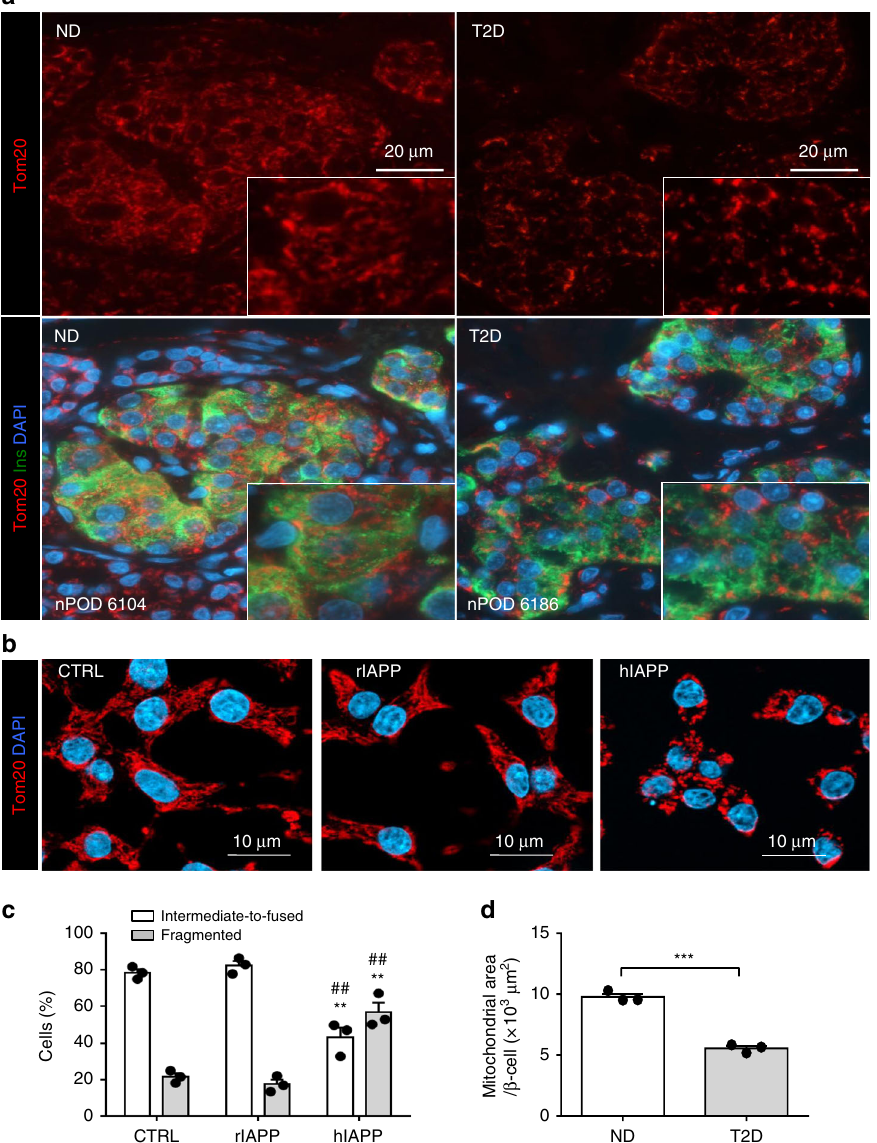
Fig. 4 β -cell mitochondrial fragmentation. a Representative immuno fl uorescence images of islets from non-diabetic (ND) and T2D patients stained for Tom20 (mitochondria, red), insulin (green), and DAPI (nuclei, blue). b Representative images of INS 832/13 stained for Tom20 (mitochondria, red) and DAPI (nuclei, blue). Cells were cultured in RPMI medium, synchronized at G1/S of the cell cycle and transduced for 36 h with adenoviral vectors expressing LacZ (CTRL) or rodent IAPP (rIAPP) or human IAPP (hIAPP). c Quanti fi cation of mitochondrial morphology in G1/S enriched INS 832/13 cells after indicated treatments to overt fragmented or overt intermediate-to-fused mitochondria. d Quanti fi cation of mitochondrial area per β -cell in ND and T2D subjects. Data are presented as mean ± SEM, n = 3 independent experiments for each group. Statistical signi fi cance was analyzed by Student t -test (** p < 0.01 relative to CTRL and ♯♯ p < 0.01 relative to